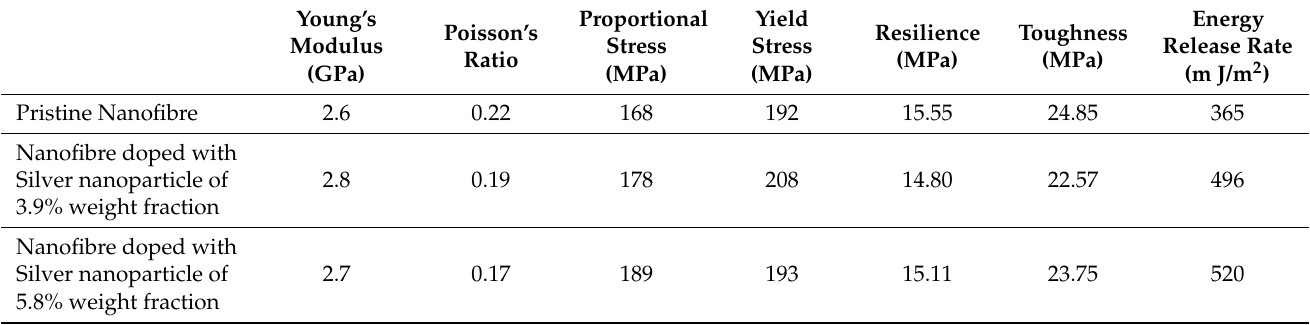
Table 1. Mechanical parameters of pristine and silver-doped nanofibres from MD